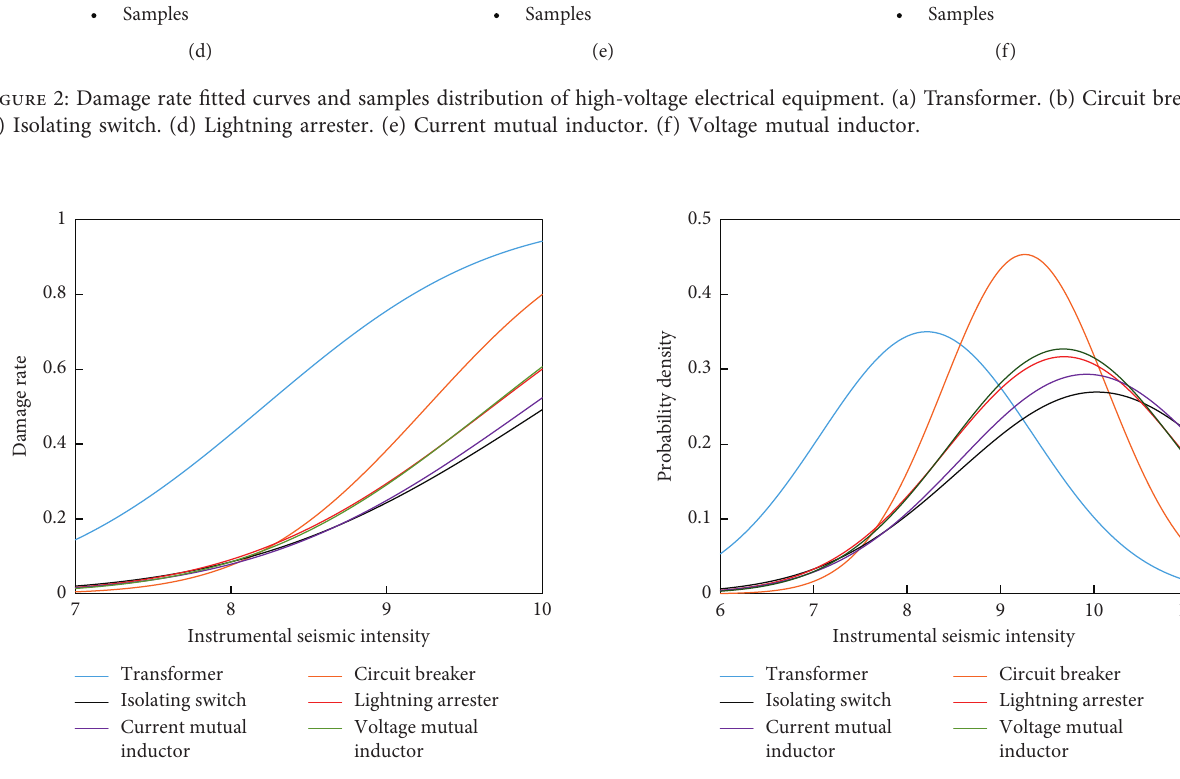
Figure 4: Probability density curves of damage rate for all kinds of high-voltage electrical